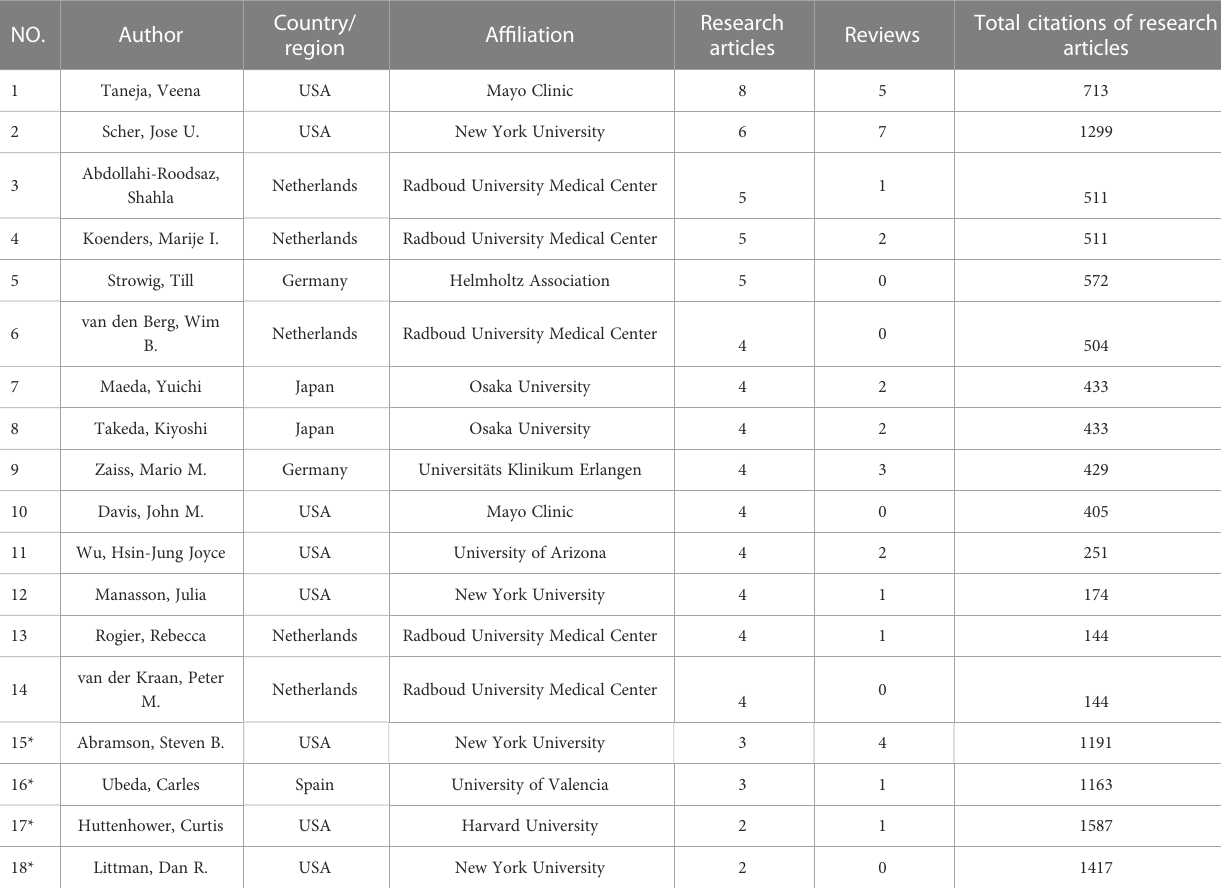
TABLE 1 The top authors with the most research articles and total citations.